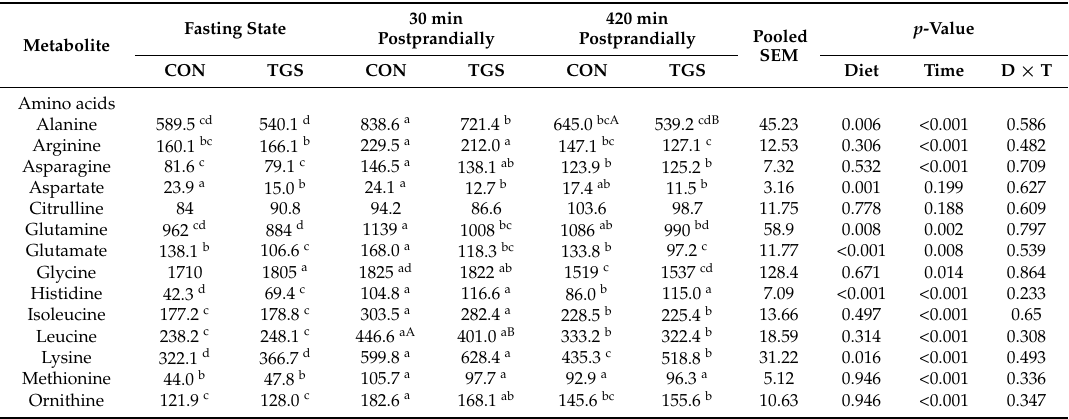
Table 2. Selected serum amino acids and biogenic amines ( µ mol/L) of pigs fed transglycosylated (TGS) or control (CON) starch diets pre- and